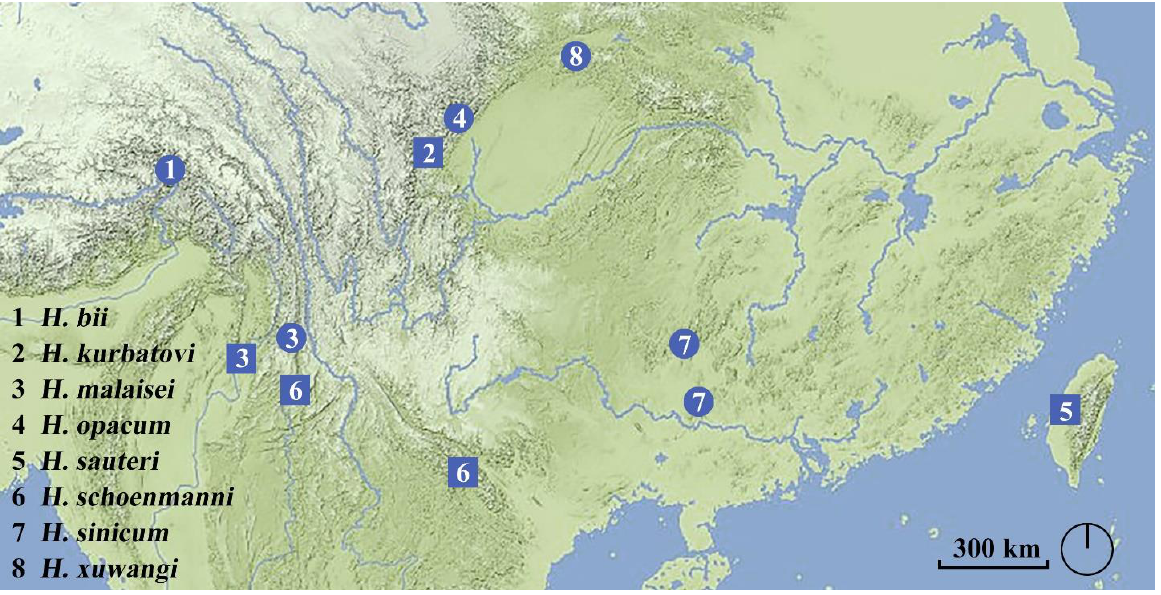
Figure 7. Distribution of all species of Hesperoschema . Circle, Localities of examined specimens in this paper; square, localities of specimens listed in previous papers.